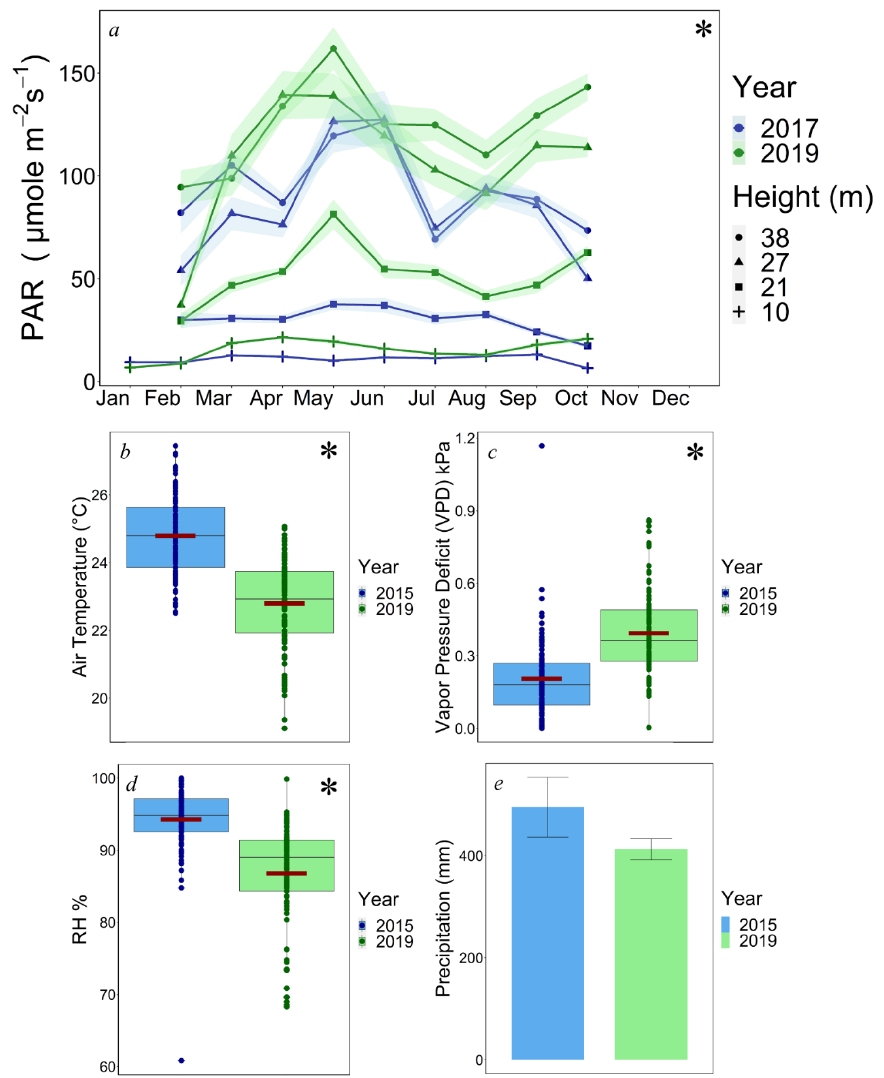
Figure 3. ( a ) Graph of monthly PAR averages for each sensor height for 2017 and 2019. ( b – d ) Side- by-side boxplots of air temperature, vapor pressure deficit, and relative humidity for 2015 and 2019. ( e ) Precipitation bar graph of 2015 and 2019. Light colored bands and error bars denote standard errors ( a , e ). Maroon bars indicate means, and asterisks denote significant differences ( b – d